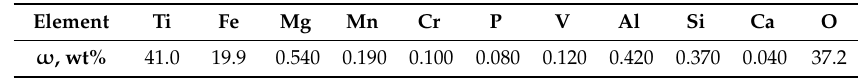
Table 1. The chemical composition of ilmenite concentrate from the Malyshevske deposit. Element Ti Fe Mg Mn Cr P V Al Si